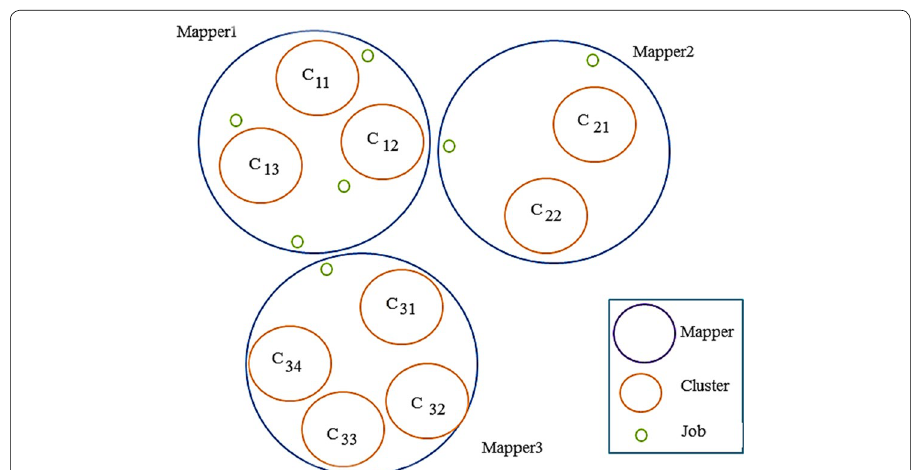
Fig. 2 Mapping with MR-DBSCAN-KD (step 1 of phase